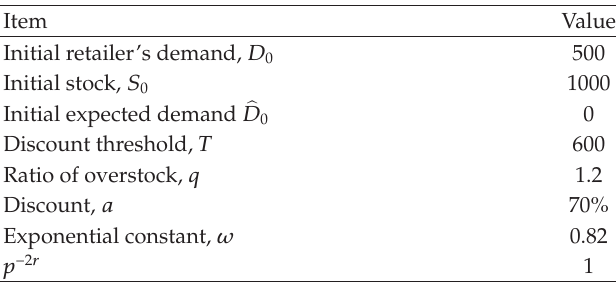
Table 1: The parameters and initial